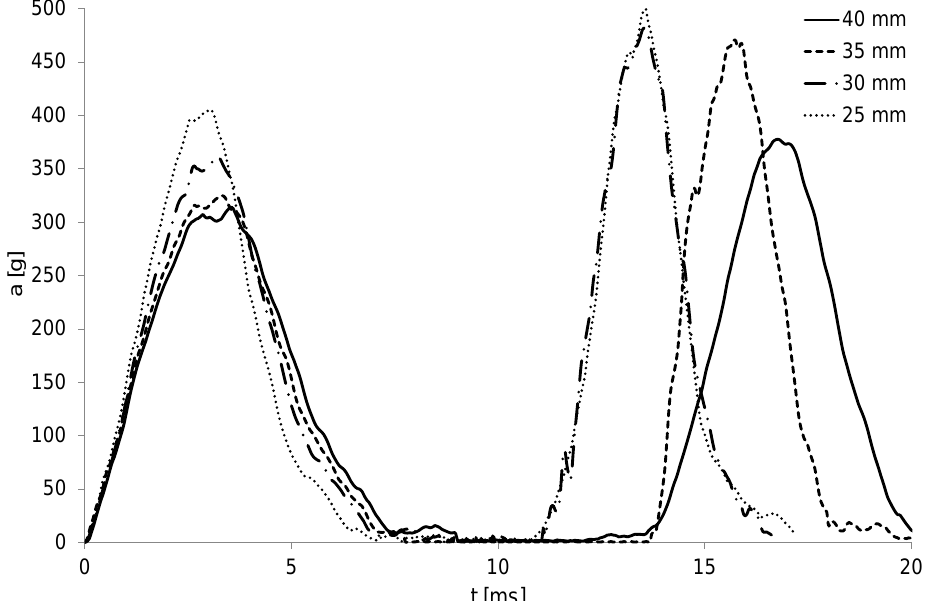
Figure 8. Acceleration-time history of double impacts performed with helmets composed of agglomerated cork liners with thicknesses ranging between 25 and 40 mm.